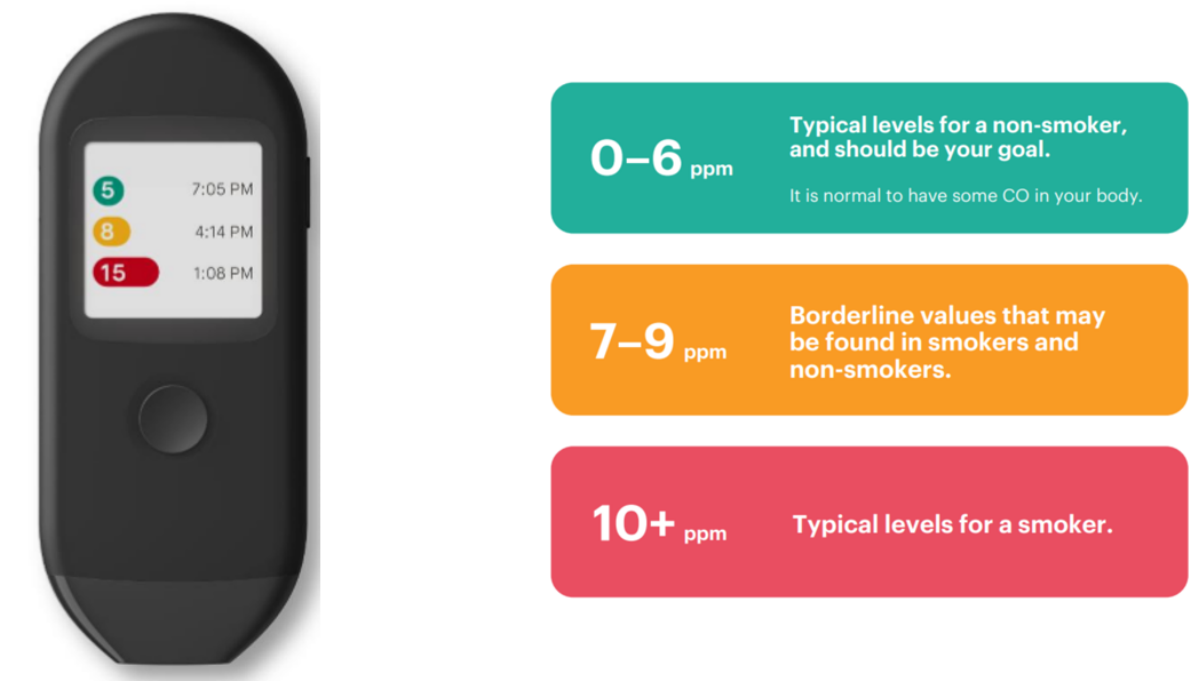
Figure 1. Pivot Breath Sensor and color coding of carbon monoxide